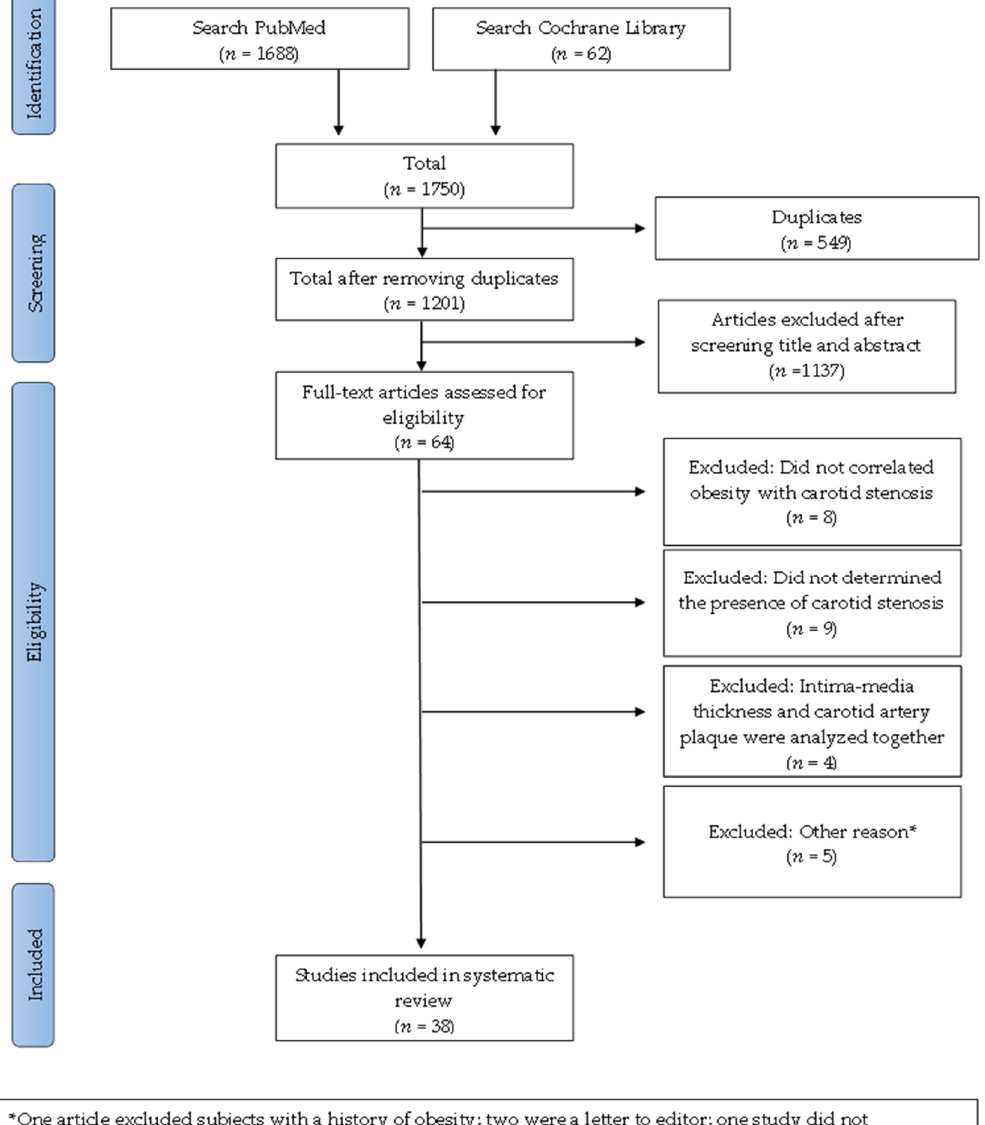
Figure 1. Flow diagram for this opportunistic review that aims to analyze the correlation between obesity and carotid atherosclerosis.